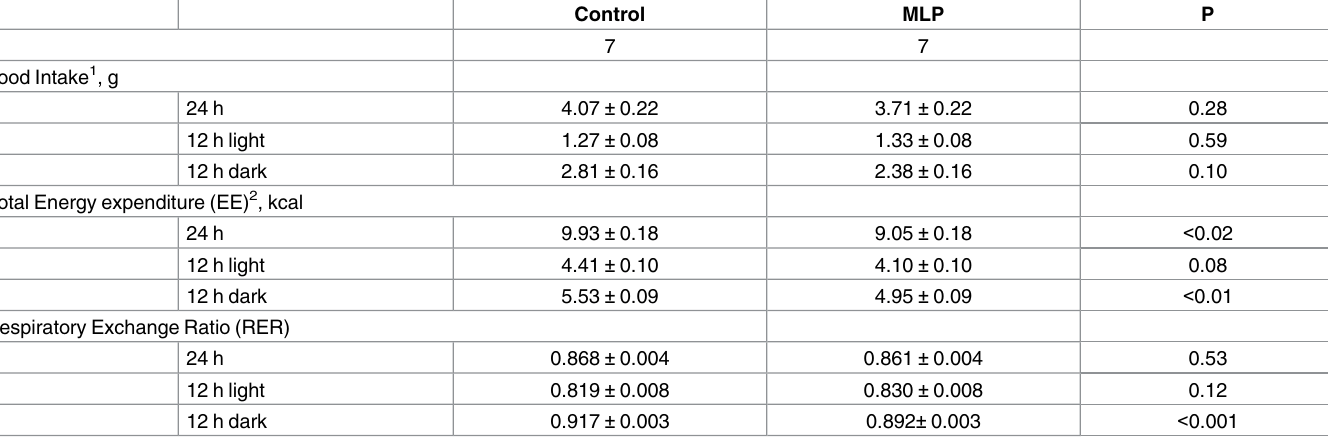
Table 1. Food intake and energy expenditure in 12-wk-old MLP and Control offspring showing values over 24 hours, and the distribution between light and dark